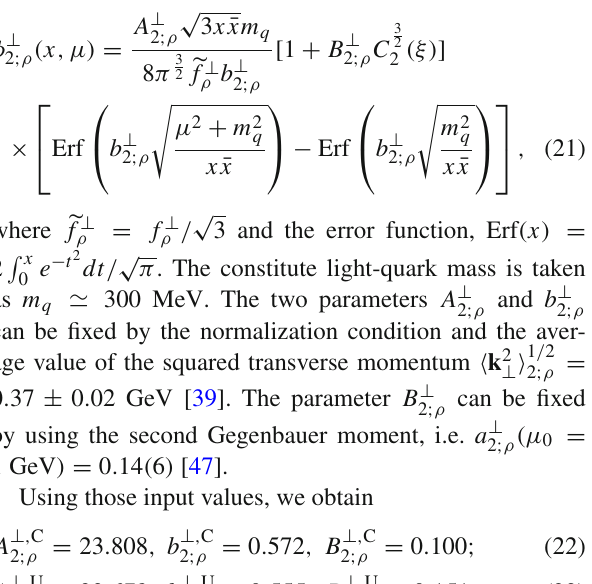
Fig. 4 The ρ -meson leading-twist LCDA φ ⊥ dicted from the WH model. As a comparison, the BB prediction [47], the Linear PM and HOPM [48], the AdS/QCD prediction [49], and the asymptotic form have also been